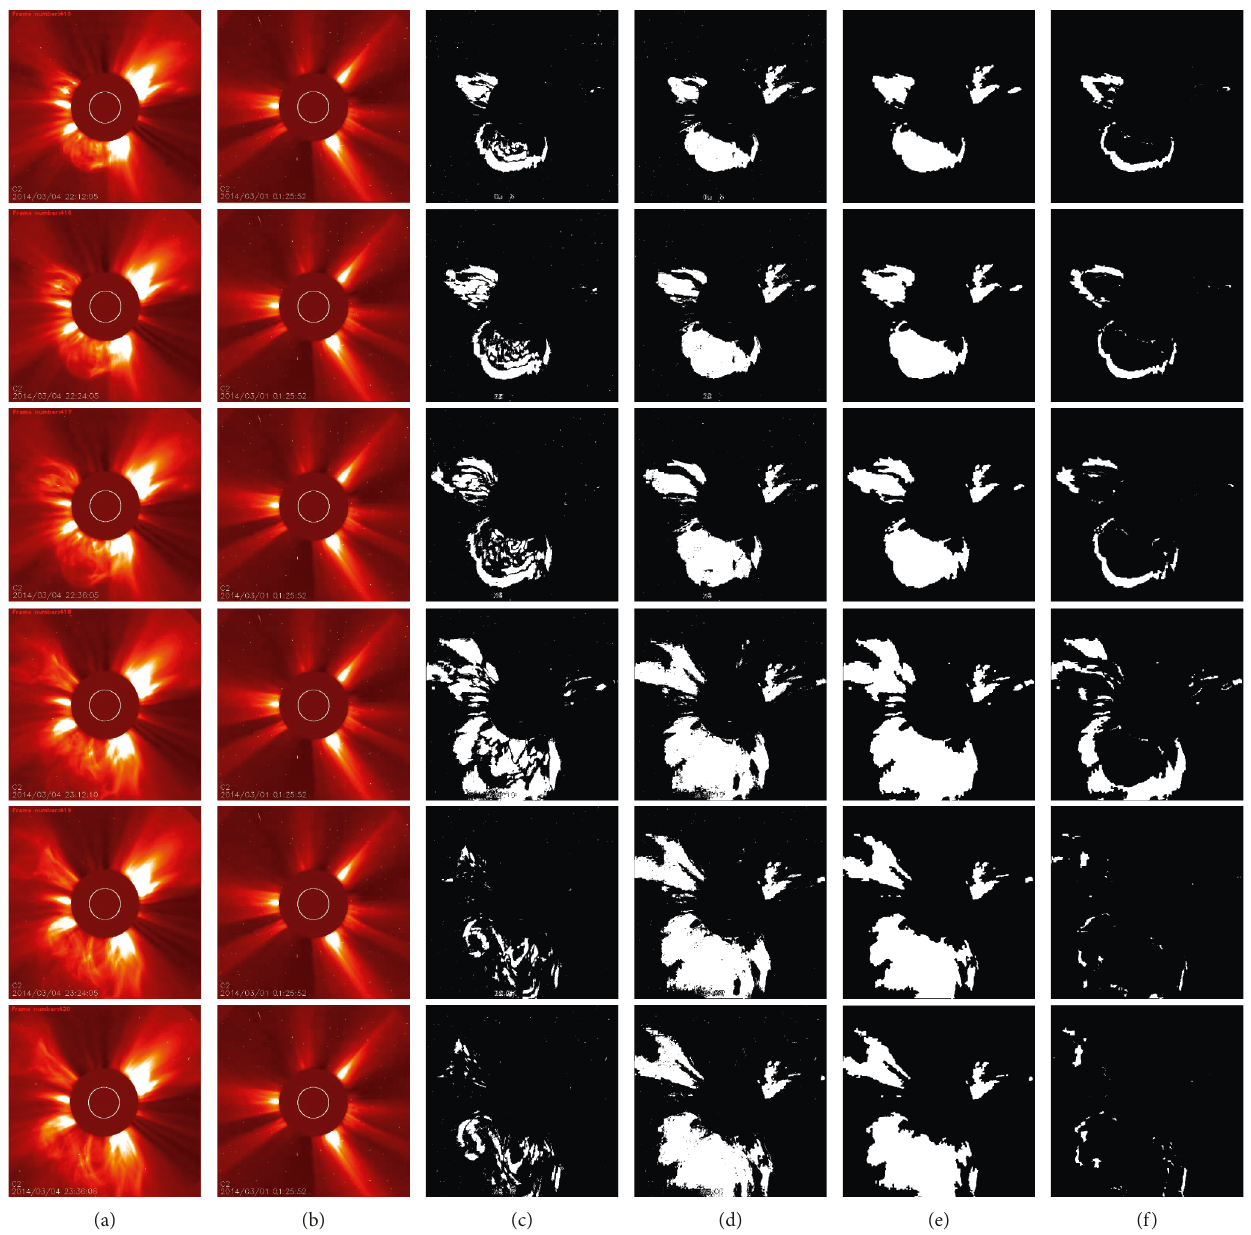
Figure 3: An experimental process graph of CME candidate area segmentation based on scene modeling. (a) LASCO C2 pseudocolor coronagraph images; (b) the reference background images; (c) the difference images between the two sequential frames; (d) the difference images between the current image and reference background; (e) the final candidate CME area images; (f) the changing region images of the candidate CME